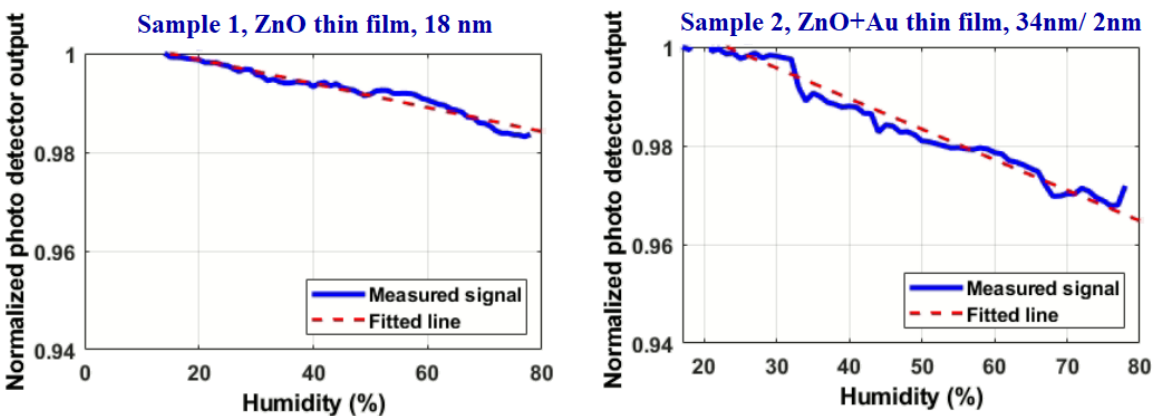
Figure 8. Response of the thin ‐ film coated samples 1 (left) and 2 (right) to the change in humidity.